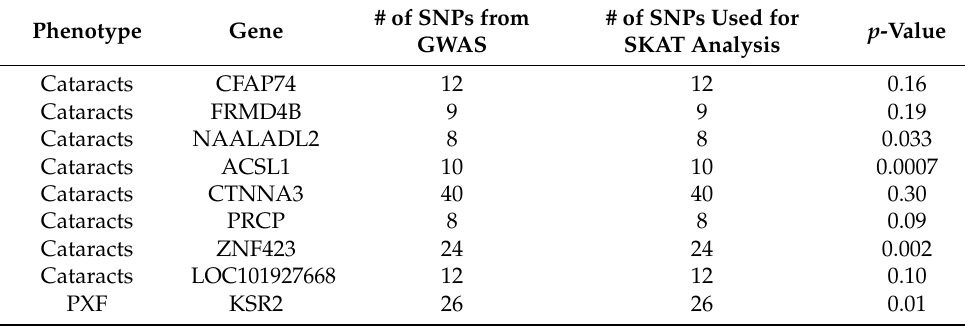
Table 8. Sequence kernel association testing